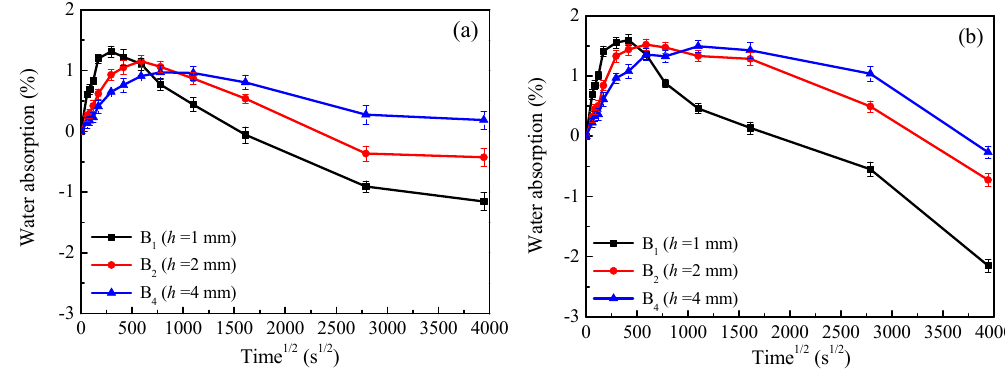
Figure 3. Water absorption of BFRP specimens soaked in 60 °C ( a ) deionized water and ( b ) alkaline solution.